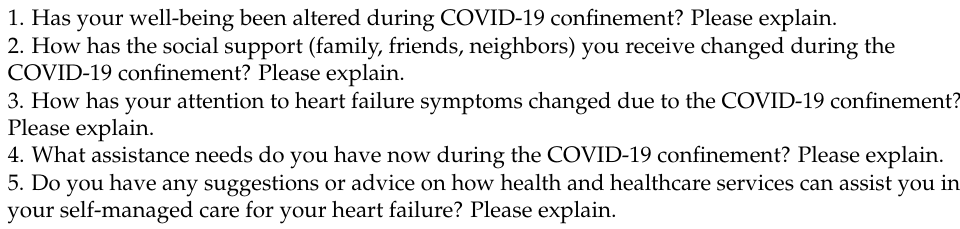
Table 1. Questions of the semi-structured